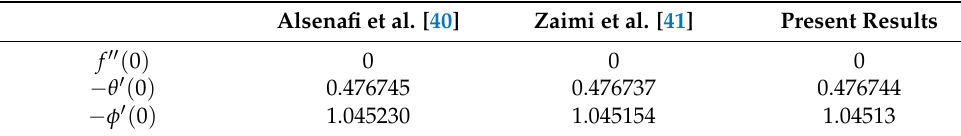
Table 1. The comparative outputs.